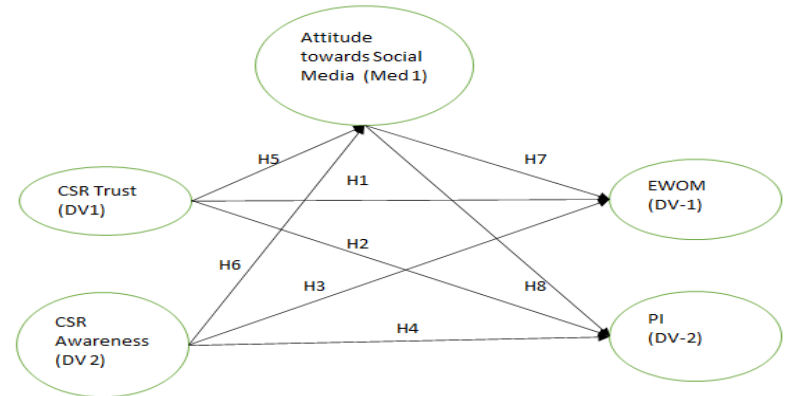
Figure 1. Research